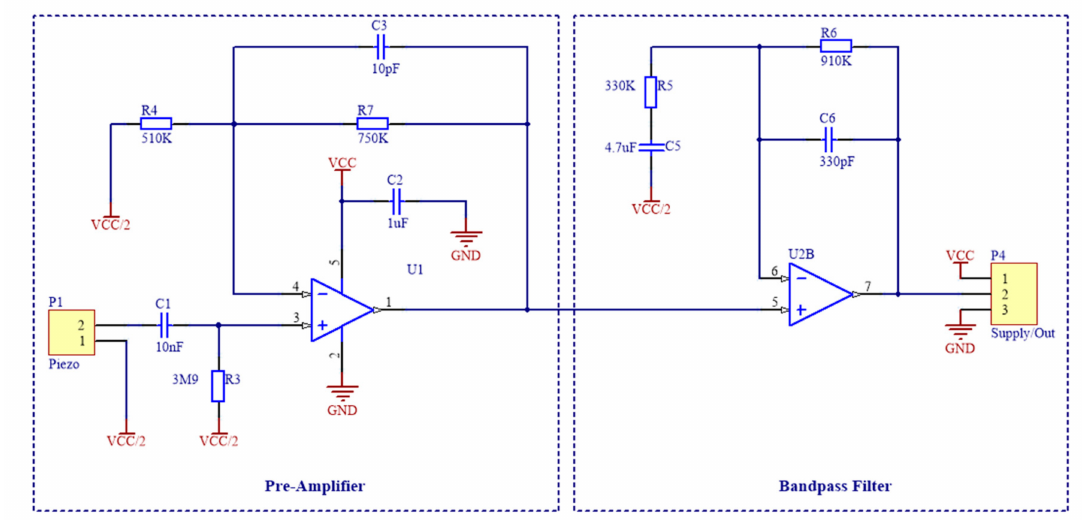
Figure 2. Schematic of the signal conditioning circuit, which is composed by a pre-amplifier for the piezoelectric sensor and a cascaded band-pass